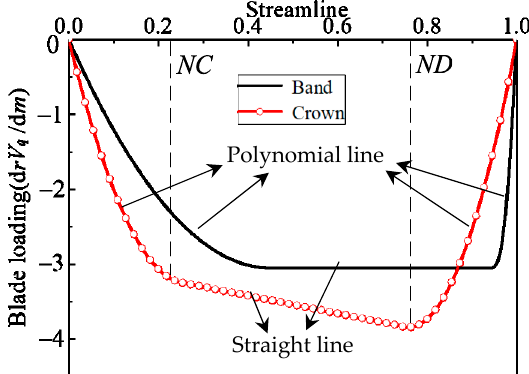
Figure 2. Blade loading distribution parameters (the horizontal axis is the normalization streamline length, and the vertical axis is the blade loading d rV q /d m ).